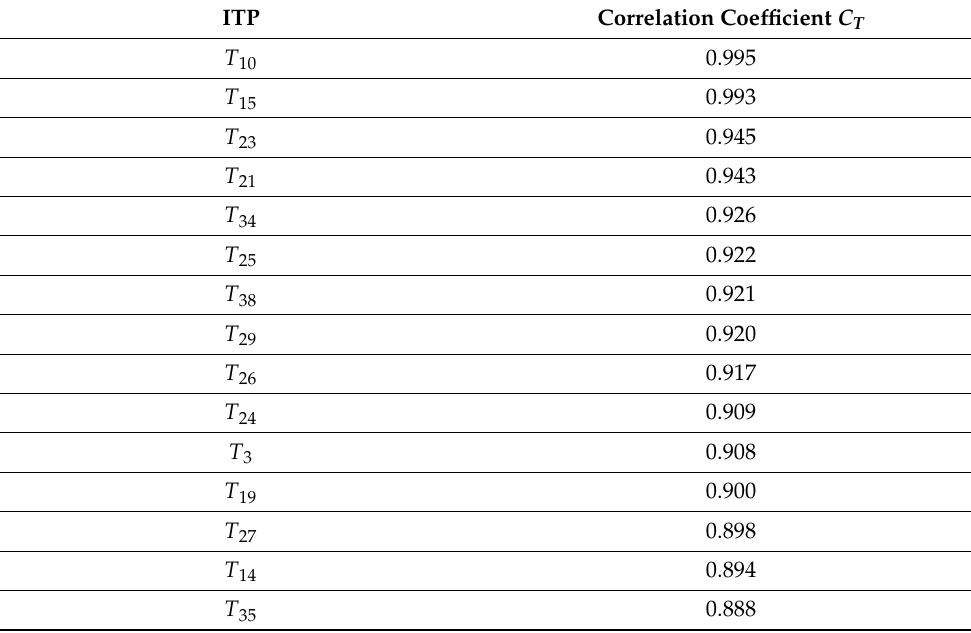
Table 6. The fifteen ITPs with the strongest correlations with T 9